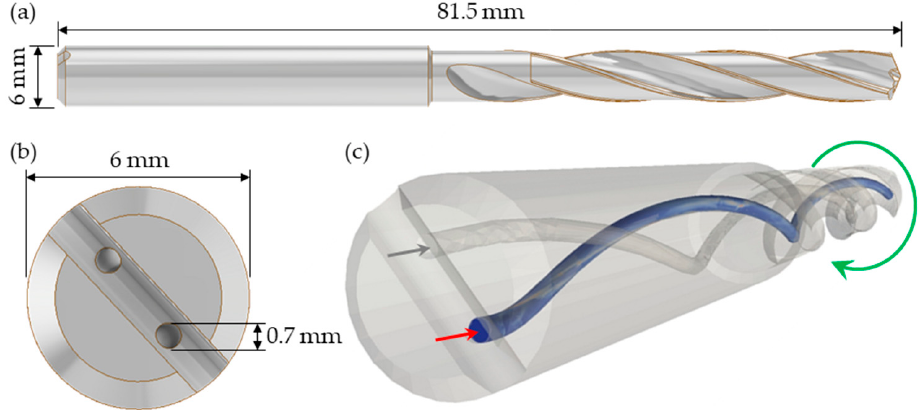
Figure 1. Sketch of the drill bit: ( a ) side view, ( b ) top view with detail of the microchannel inlet, and ( c ) internal microchannel is highlighted; the red arrow indicates the flow direction while the green arrow indicates the rotation direction of the drill bit.